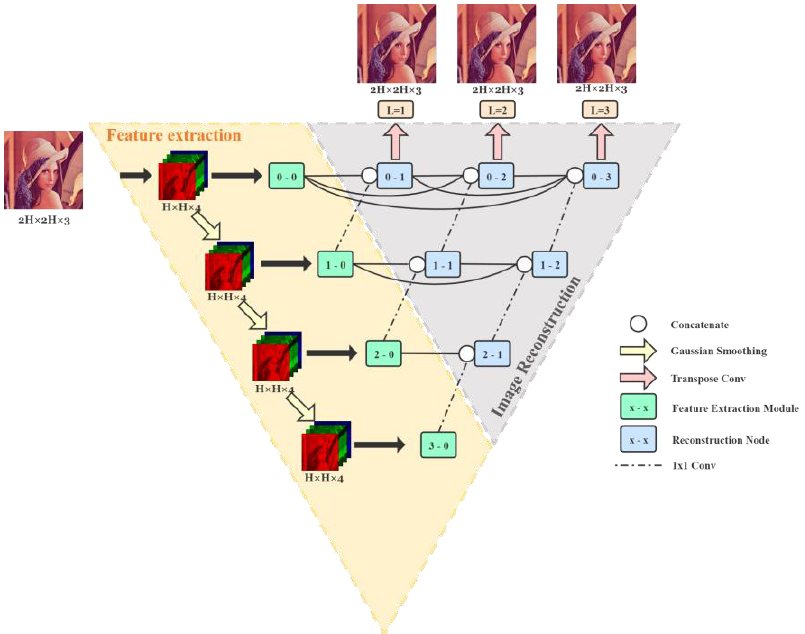
Figure 2. Network structure: yellow box indicates the image feature extraction part, and the gray box indicates the image reconstruction part.